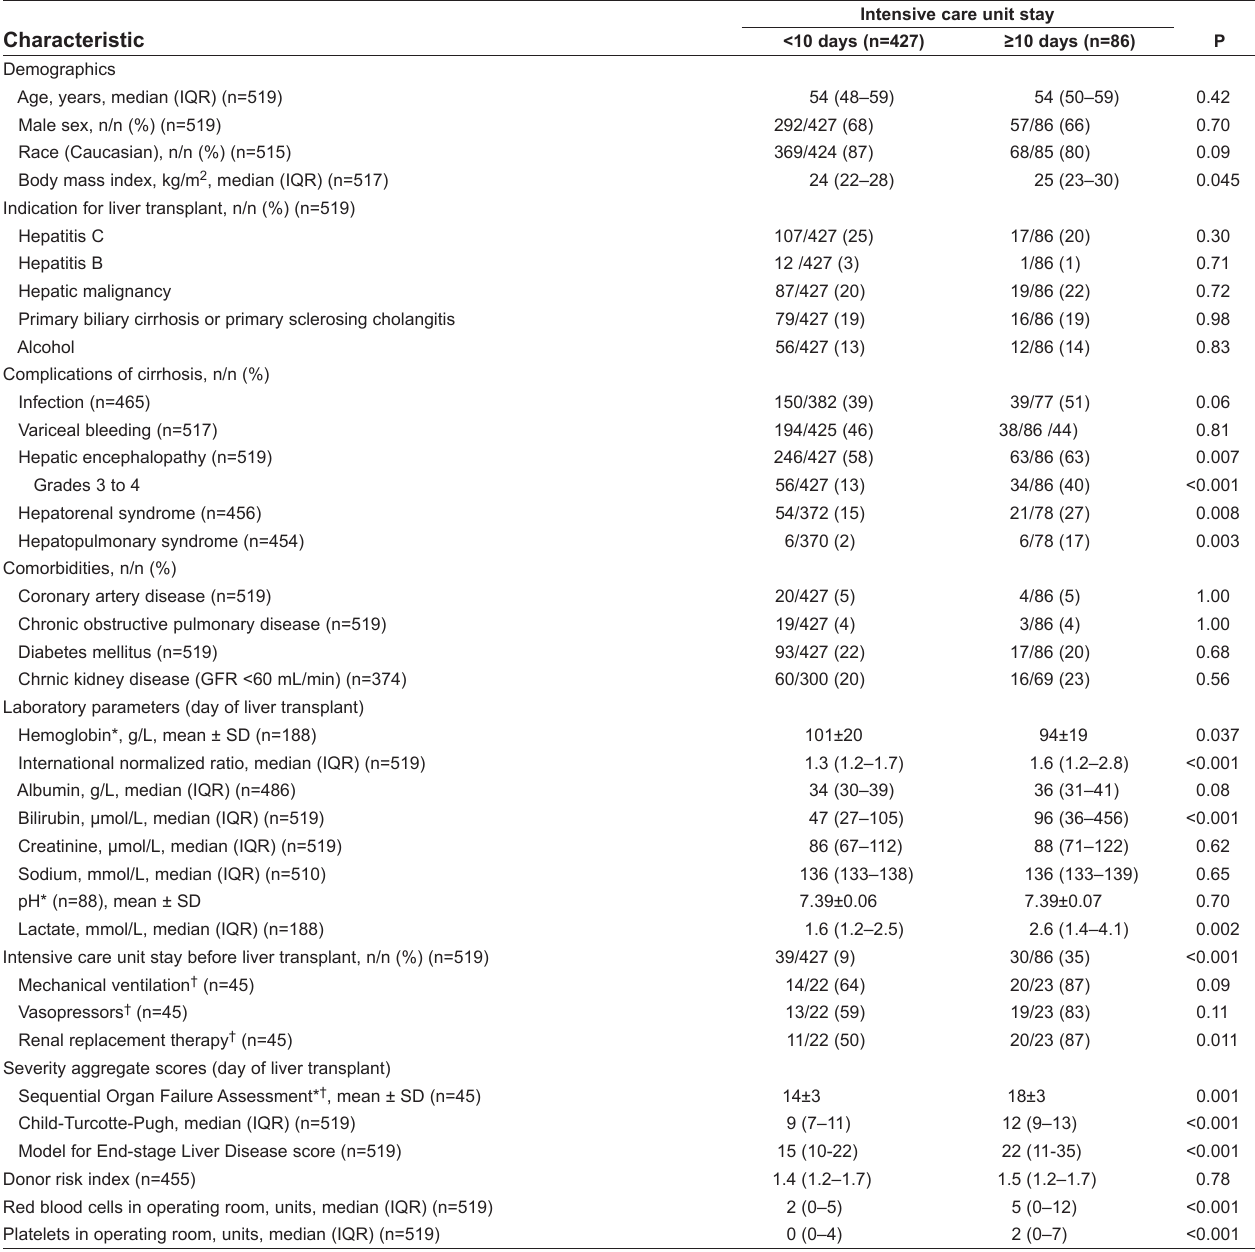
TABLE 2 Analysis of patients’, donors’ and perioperative characteristics for the entire cohort and according to duration of the first intensive care unit stay after liver transplant (≥10 days versus <10